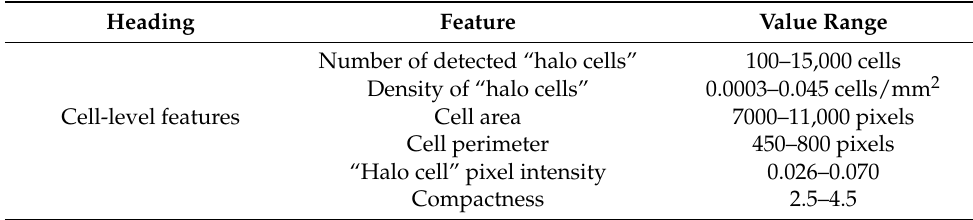
Table 2. Cell-level features of the cases